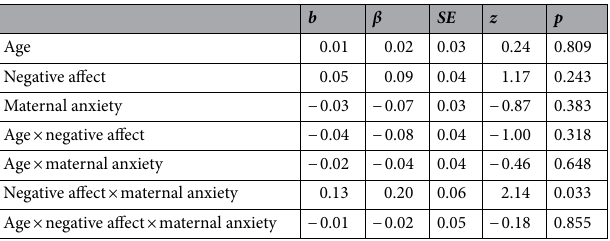
Table 6. Regression assessing contributions of age, negative affect and maternal anxiety to probability of vigilant group membership.